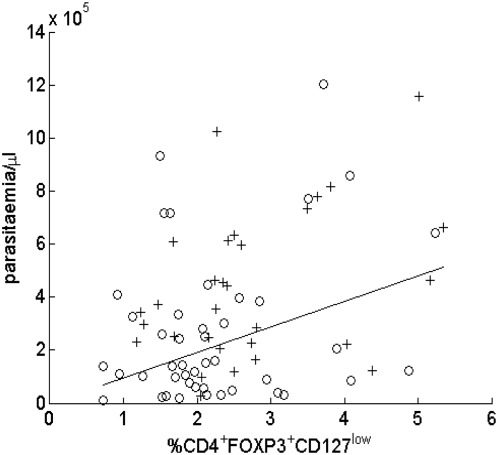
Proportion of T cells expressing a Treg phenotype correlates with parasitaemia.Parasite density in peripheral blood is plotted against the proportion of Tregs. +: severe cases; ○: uncomplicated cases. P value for linear regression ignoring disease status: 0.002. (gradient for separate lines for uncomplicated and severe cases not significantly different).